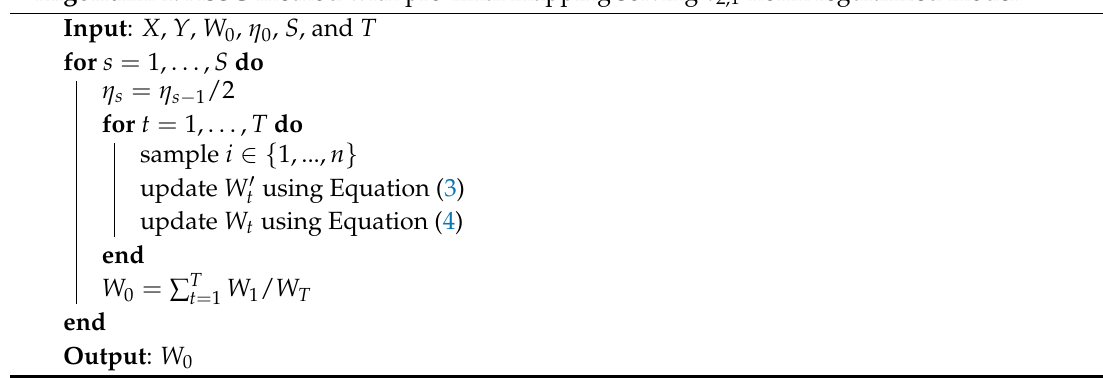
Algorithm 1: ASSG method with proximal mapping solving (cid:96) 2,1 -norm regularized model.